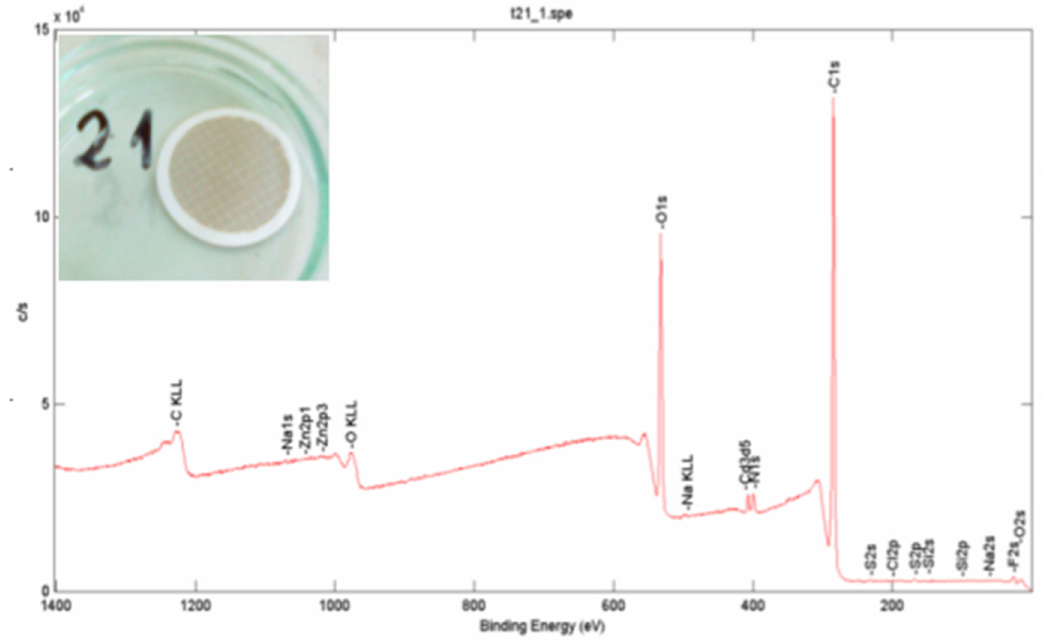
Figure 7. Example of the XPS spectrum in the energy range 0–1400 eV for the PM 4 in the house with ETS in Jaworzno.